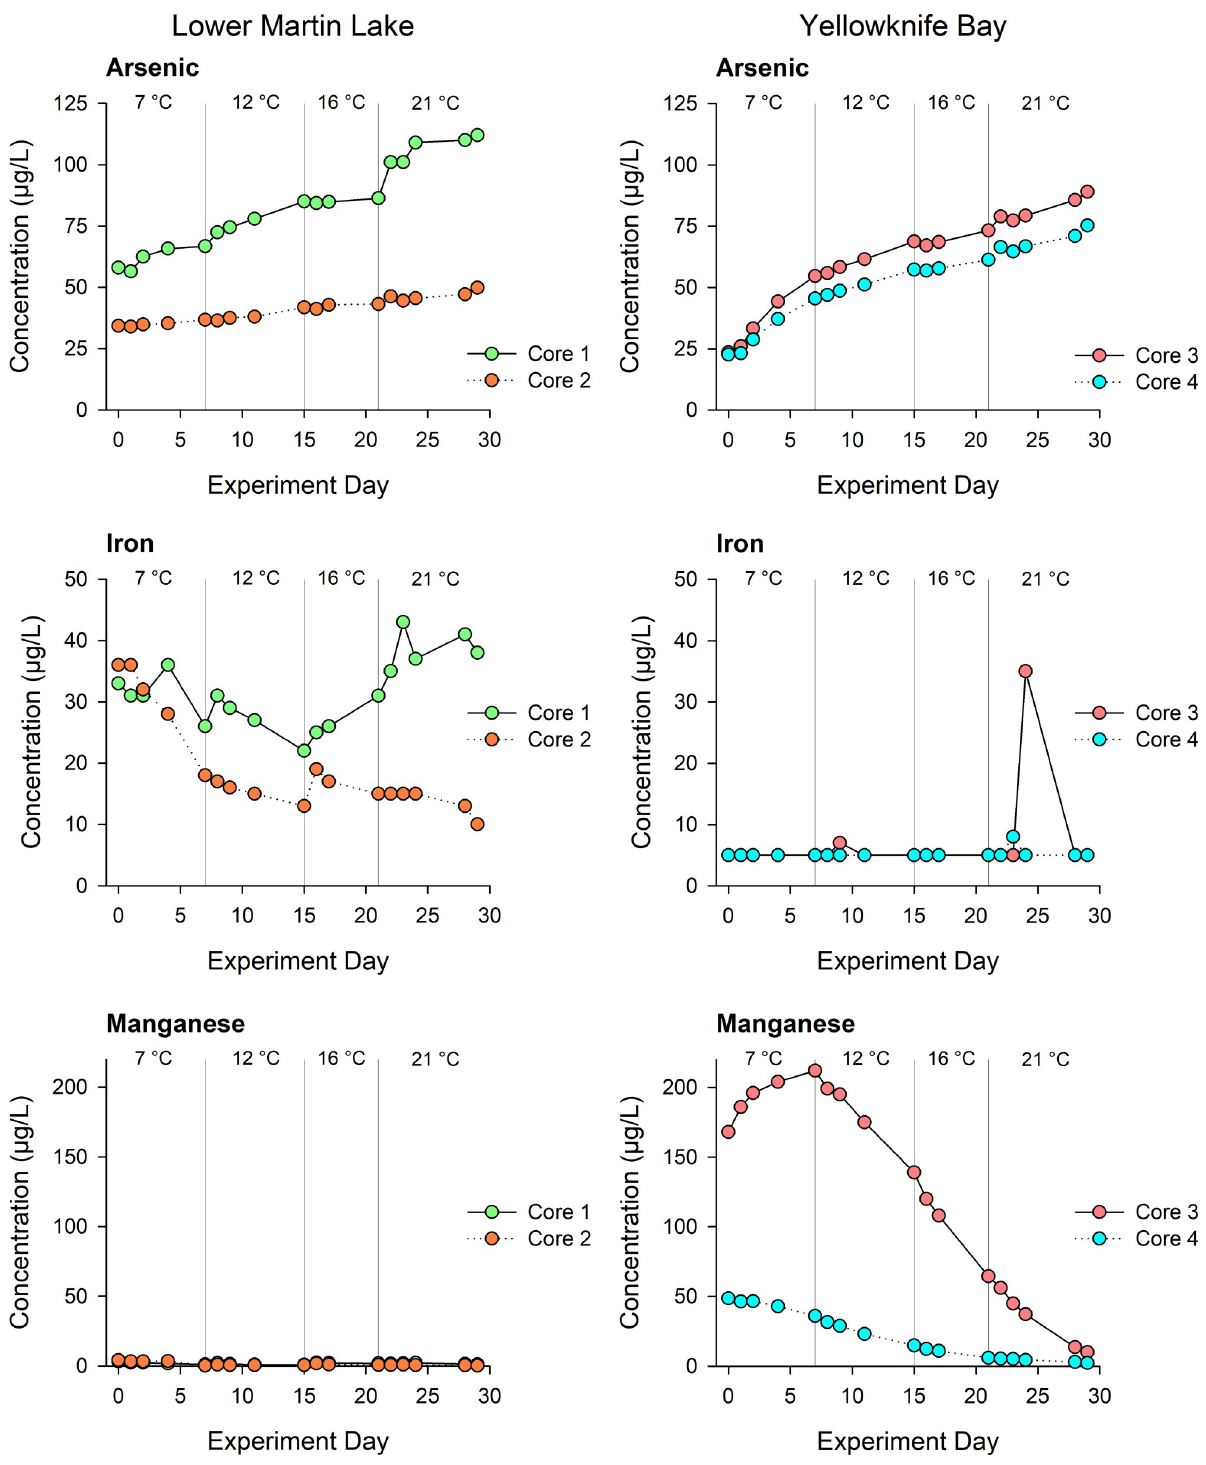
Fig 3. Time series of metal(loid) concentrations in overlying water. Metal(loid) concentrations of As, Fe, and Mn in overlying water in duplicate Lower Martin Lake and Yellowknife Bay cores throughout the 30-day experiment. Each vertical grey line represents the start date of a new temperature treatment. The precision of As, Fe, and Mn concentrations is estimated at < 9% based on the average RSD of seven duplicate measurements.